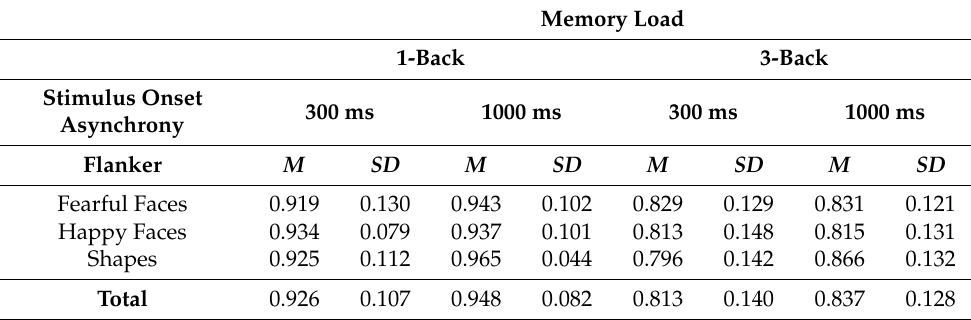
Table 13. Means and SDs of participants’ accuracy rates for Study